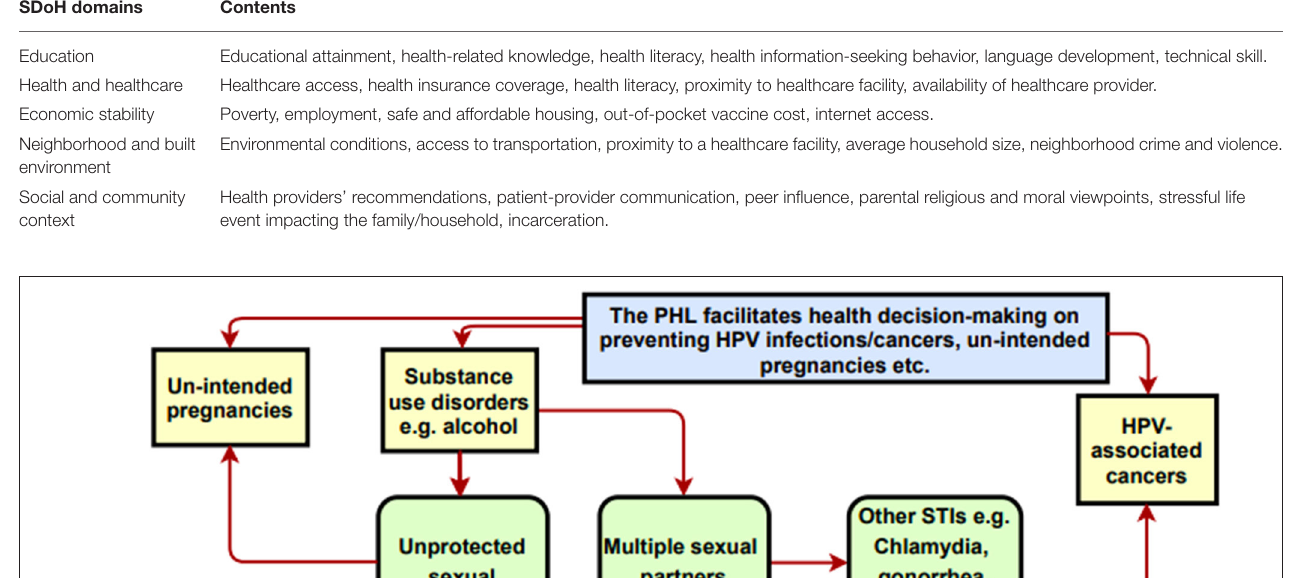
protocols (21–23). Additionally, most college-age students did not perceive themselves to be at risk of acquiring HPV